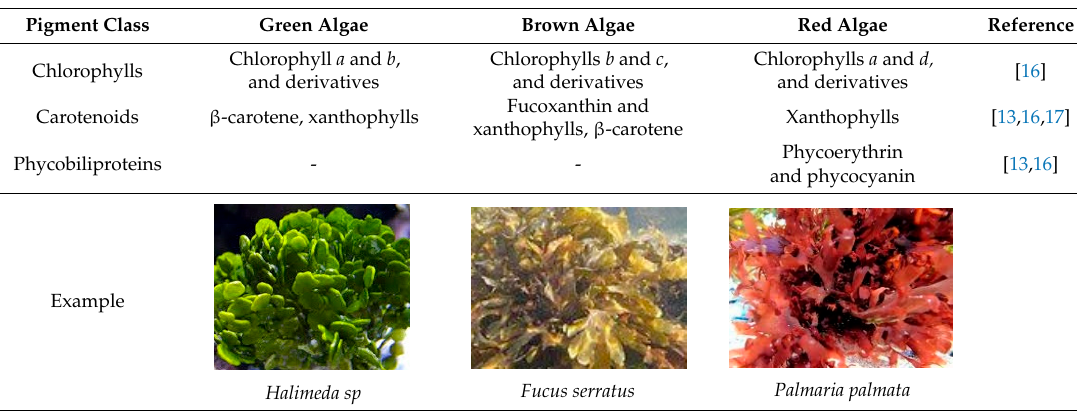
Table 2. Pigment content of the 3 common groups of macroalgae. Bold pigments represent the predominant ones in each group.